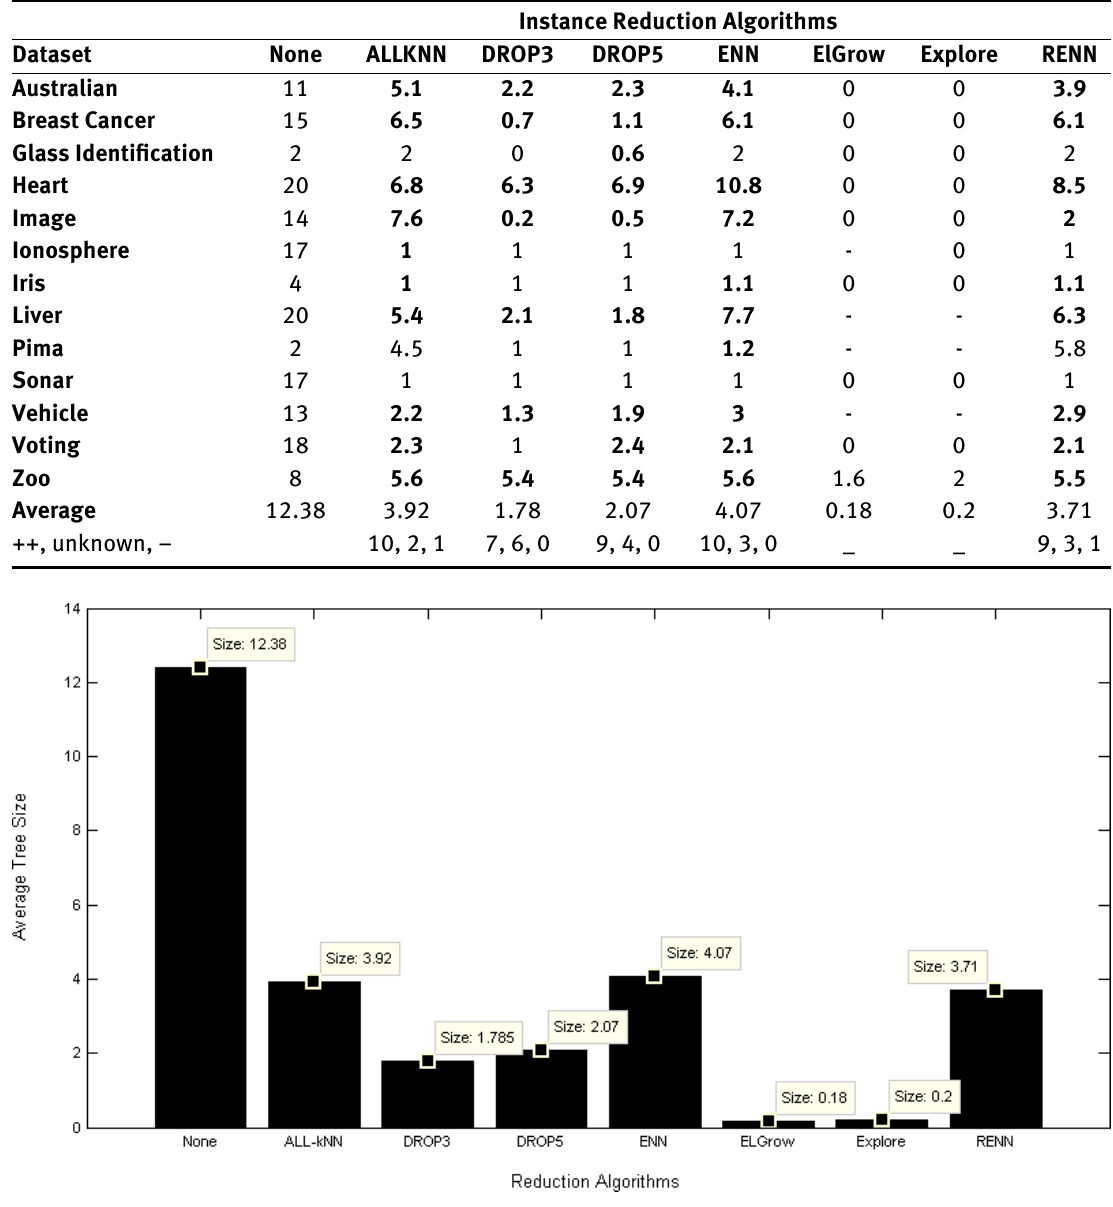
Figure 3: Average Tree Size (Number of Nodes) for Unpruned Trees With 0% Noise Ratio